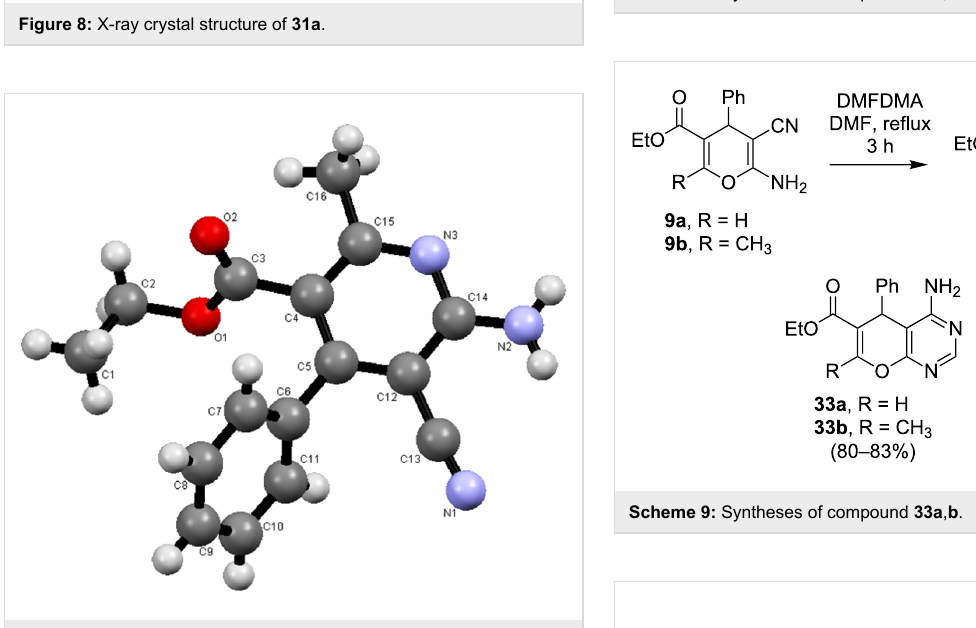
Scheme 8: Syntheses of compound 31a , b .